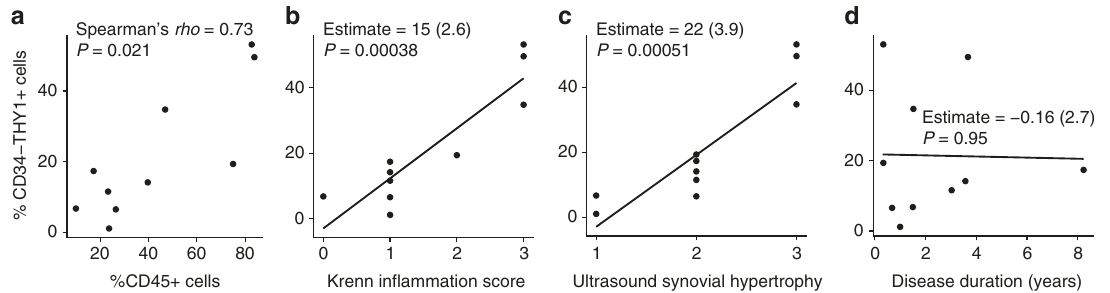
Fig. 4 Correlation between proportion of fi broblast subsets and synovial in fl ammation. a The Spearman's correlation between the proportion of CD34 – THY1 + fi broblasts in total fi broblasts and the proportion of CD45 + cells in total live cells in synovial tissue biopsies from RA knee joints. b – d The linear correlation coef fi cient between the proportion of CD34 – THY1 + fi broblasts and Krenn in fl ammation score ( b ), ultrasound synovial hypertrophy score ( c ), and disease duration (years) ( d ). Proportion of cells were evaluated by fl ow cytometry. Plots b – d show linear model coef fi cient estimates and t test P values